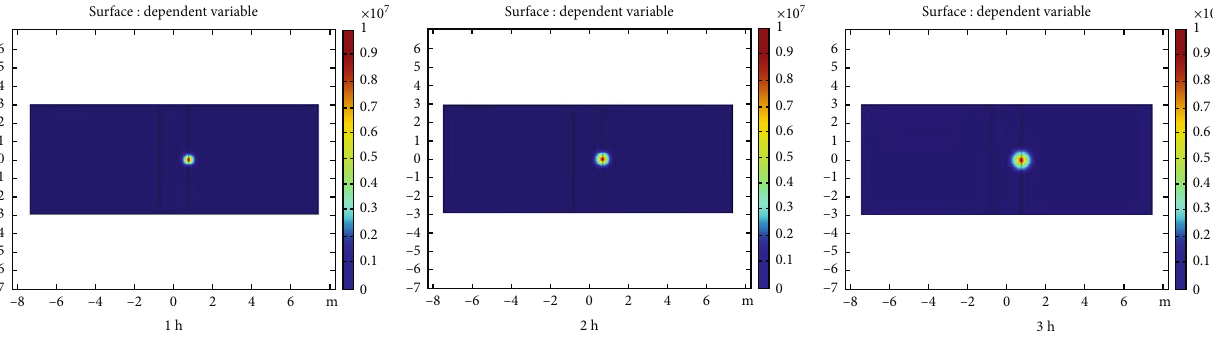
Figure 20: Cloud map of carbon dioxide pressure over